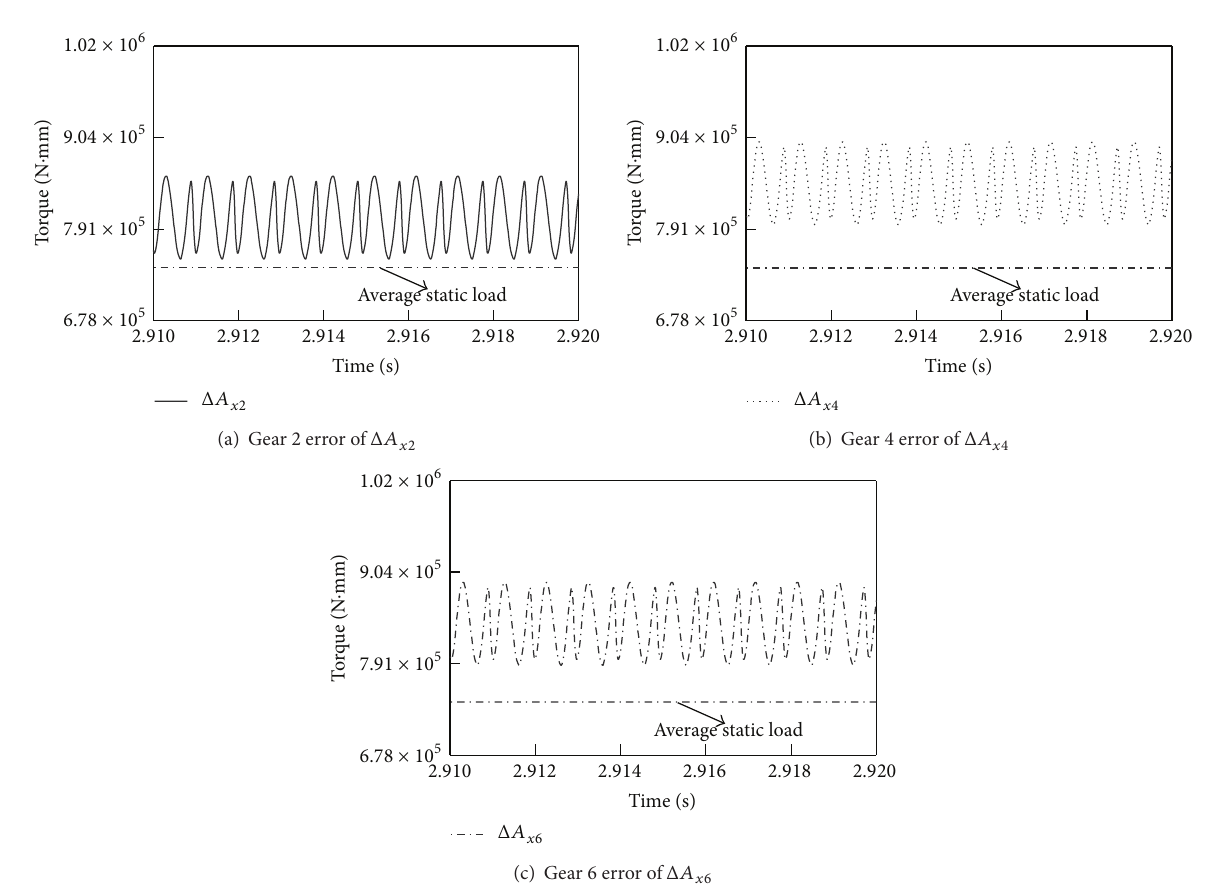
Figure 13: Load-sharing characteristics changed with installation